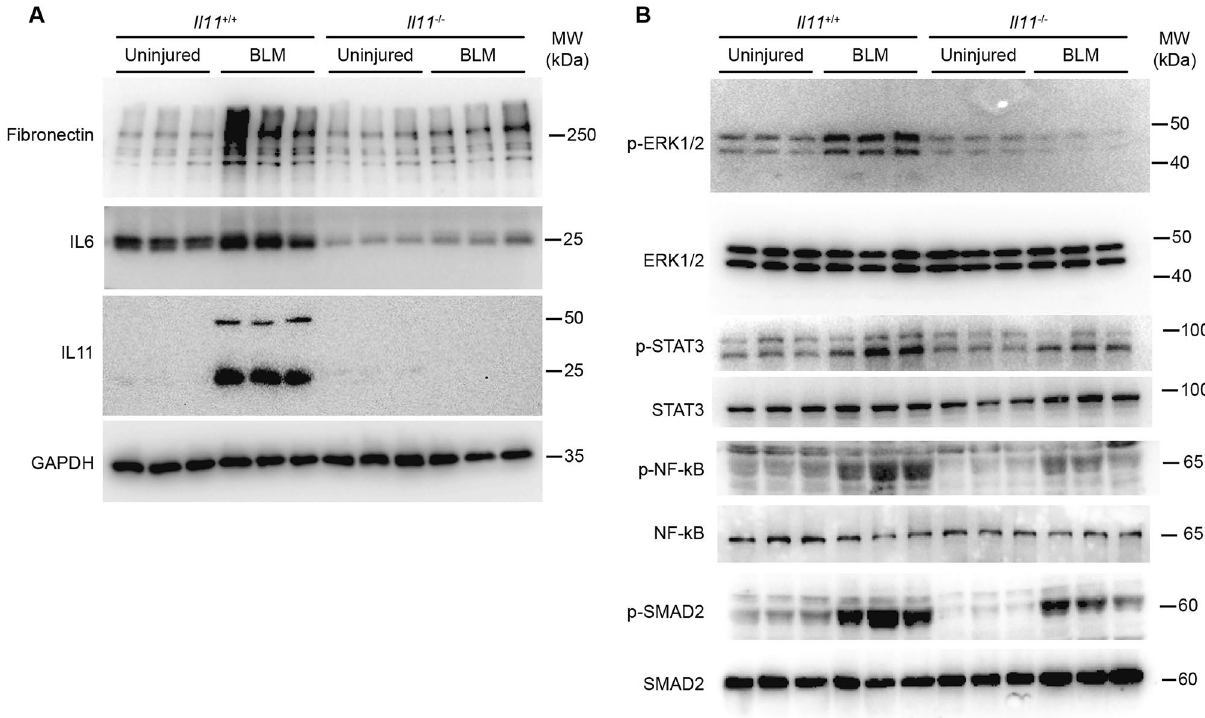
Figure 5. Bleomycin-induced pulmonary fibronectin, IL6, IL11 expression and ERK, STAT3, NF-kB and SMAD2 phosphorylation in Il11 knockout and wild type mice. Western blots of ( A ) fibronectin, IL6 and IL11 and ( B ) phosphorylated and total protein levels ERK1/2, STAT3, NF-kB and SMAD2 in lung homogenates of Il11 −/− and wild-type mice 14 days post-BLM ( n = 3 for each